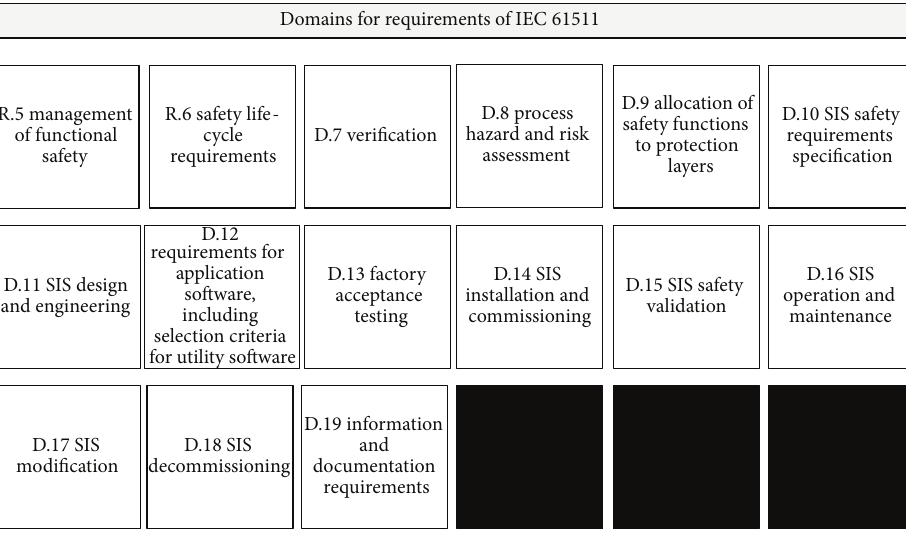
Figure 5: Domains for safety requirements of IEC